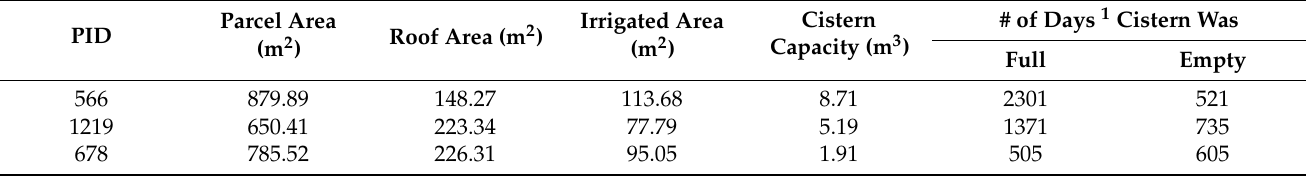
Table 4. Summary of configuration of 3 parcels with roof runoff harvesting cisterns.